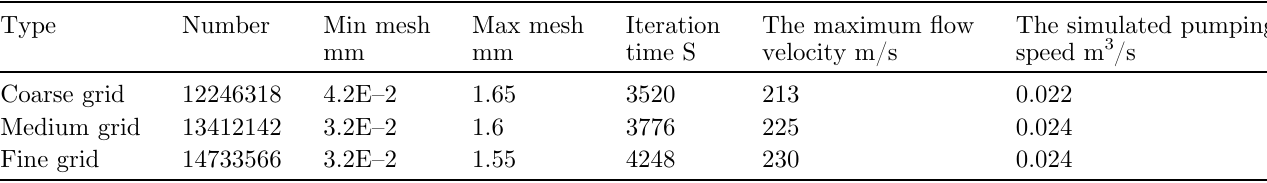
Table 3. The grid of fl uid domain.